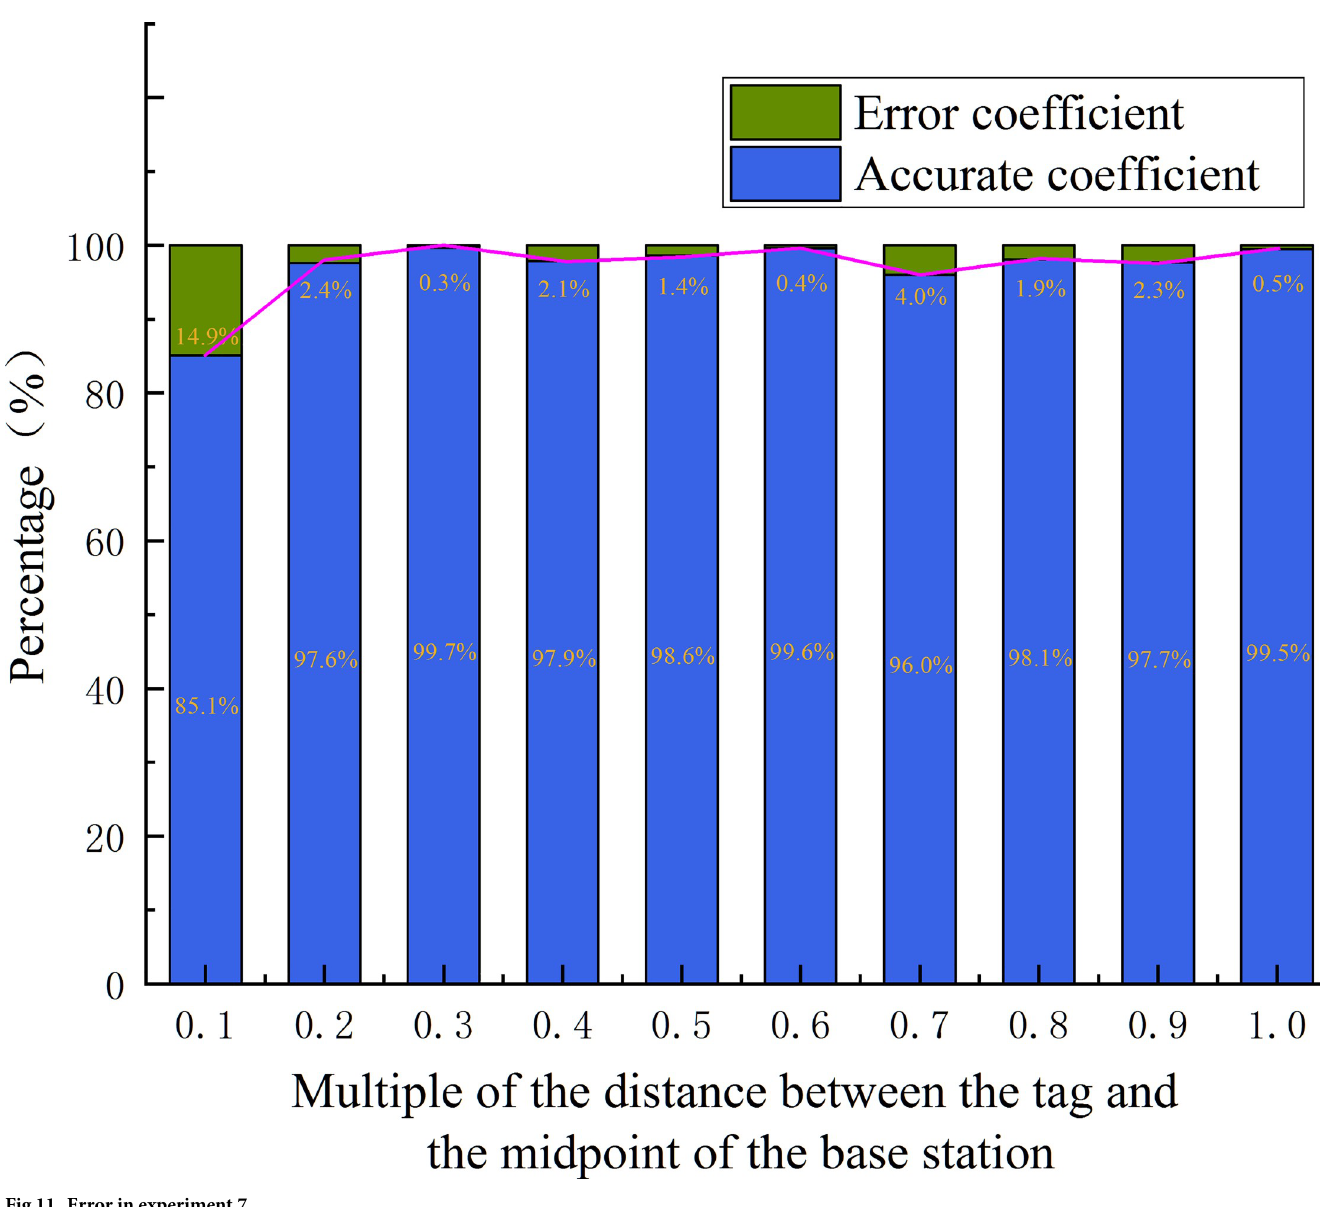
Fig 11. Error in experiment